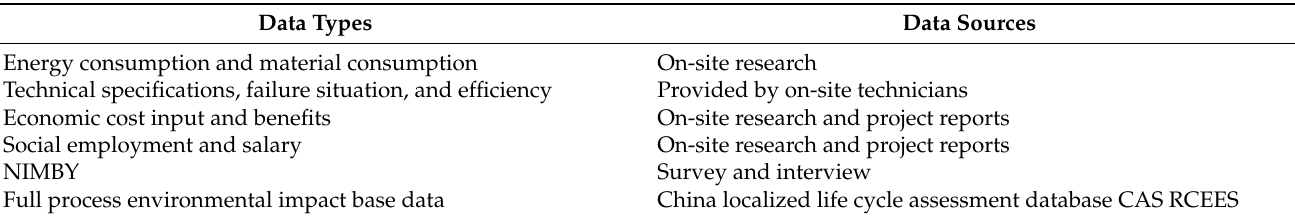
Table 12. Description of data types and